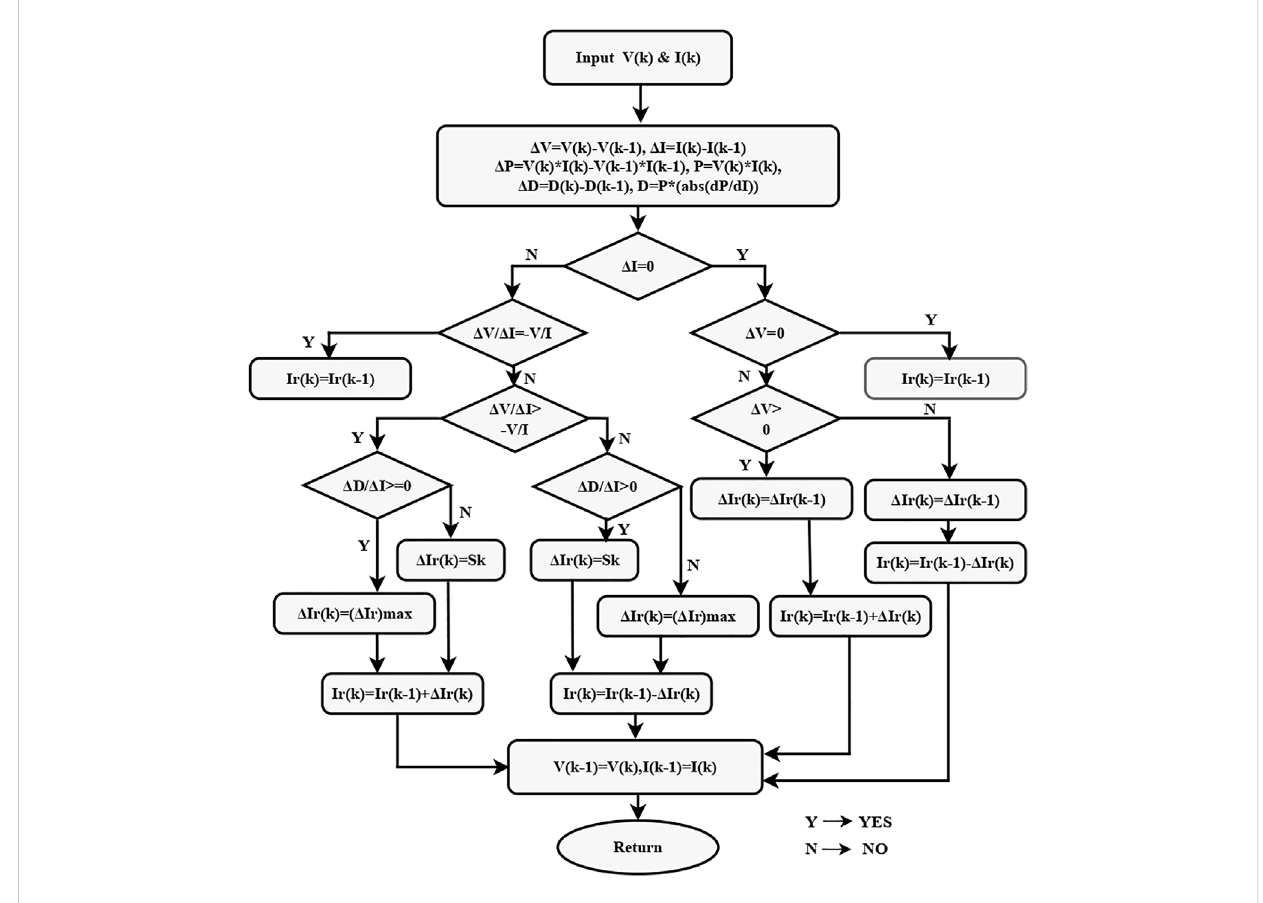
FIGURE 5 MPPT algorithm based on VSS – INC